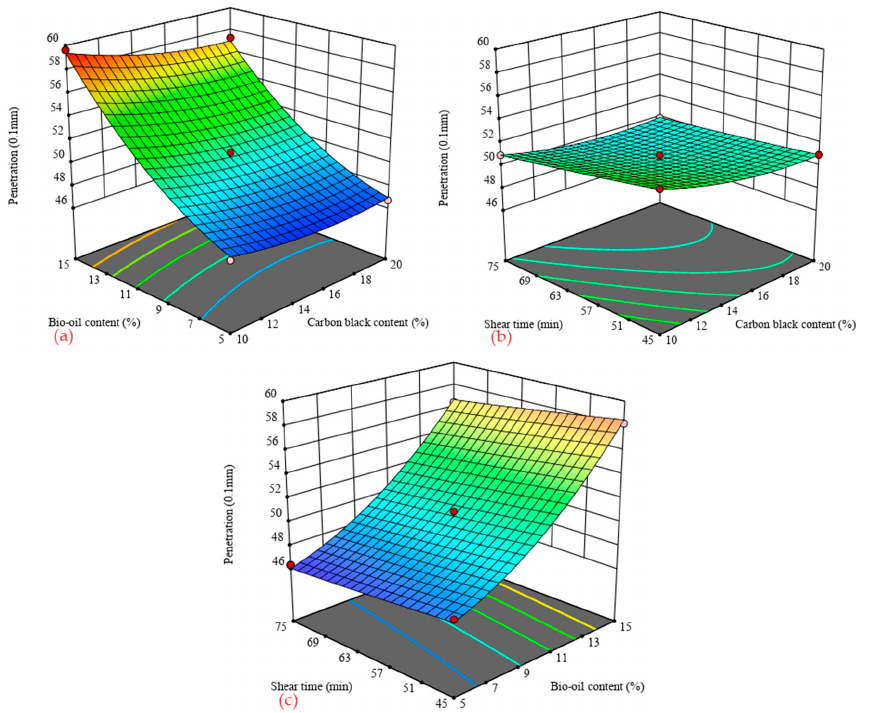
Figure 3. 3D surface of penetration with influence factors. ( a ) shear time = 60 min; ( b ) bio-oil content = 10%; ( c ) carbon black content = 15%.